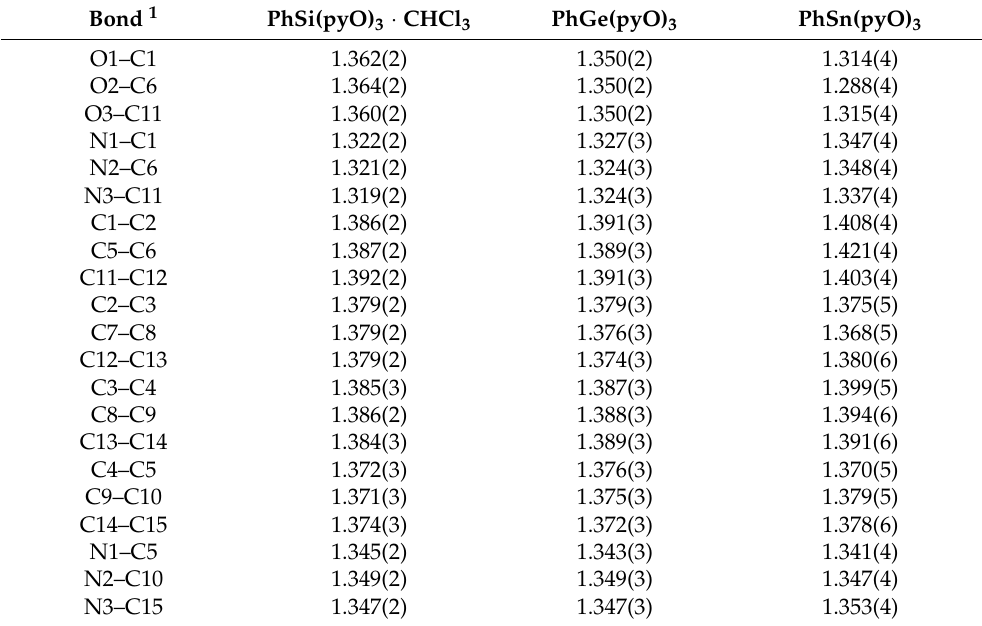
Table A2. Bond lengths [Å] of the pyridine-2-olate moieties in PhSi(pyO) 3 · CHCl 3 , PhGe(pyO) 3 and PhSn(pyO) 3 .